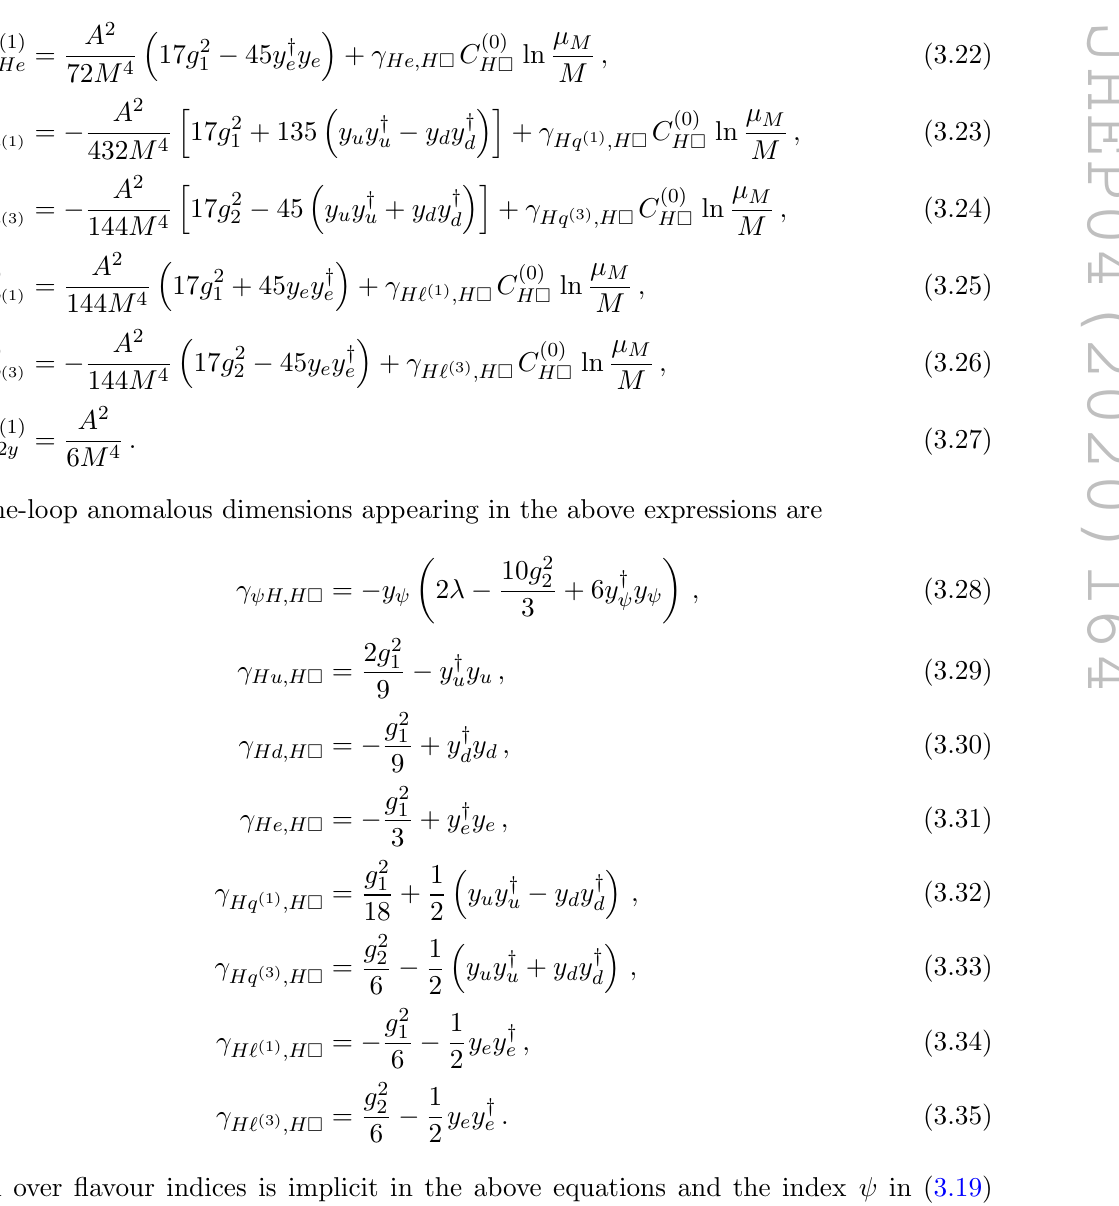
Figure 11 . Examples of one-loop heavy-light scalar diagrams that need to be considered to extract the one-loop matching corrections of the fermionic dimension-six SMEFT operators in (3.4). The line styles and their meanings duplicate those of (cid:12)gure